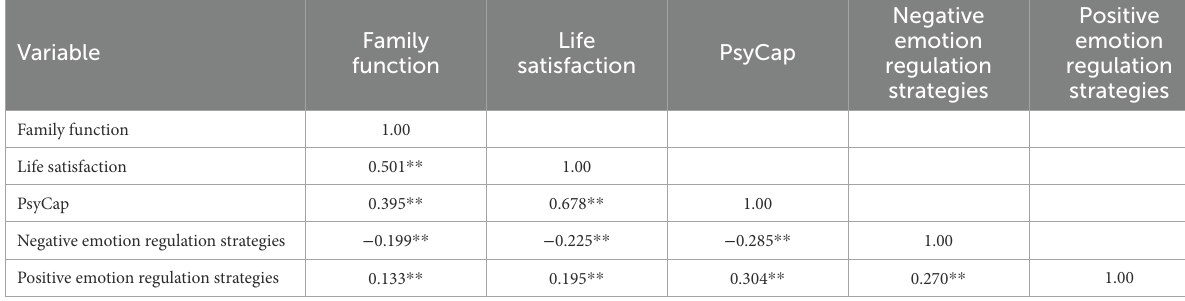
TABLE 3 Correlation analysis of family function, life satisfaction, PsyCap, and cognitive-emotion regulation.